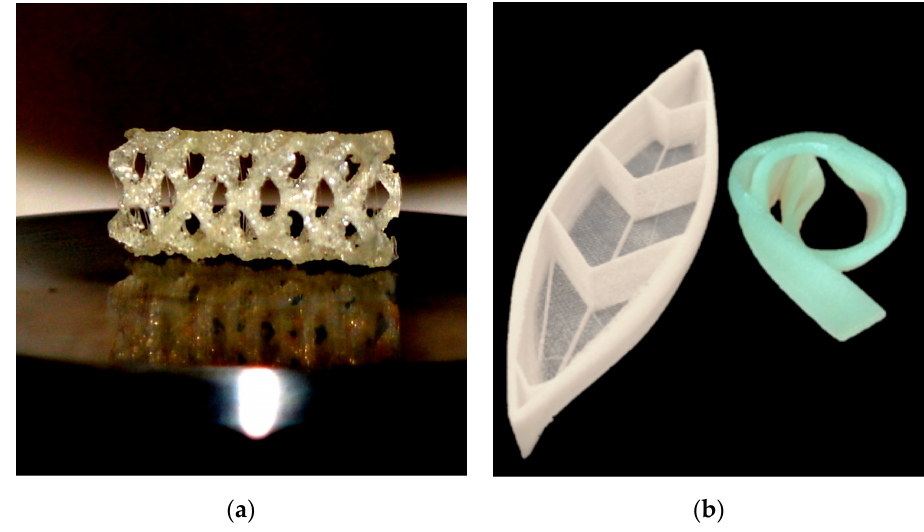
Figure 1. Examples of 3D-printed applications of Shape Memory Polyurethane (SMPU) by EBAM. ( a ) A photograph of an iN–House 3D-printed generic stent and ( b ) 3D-printed kayak prototype based on reference [7].